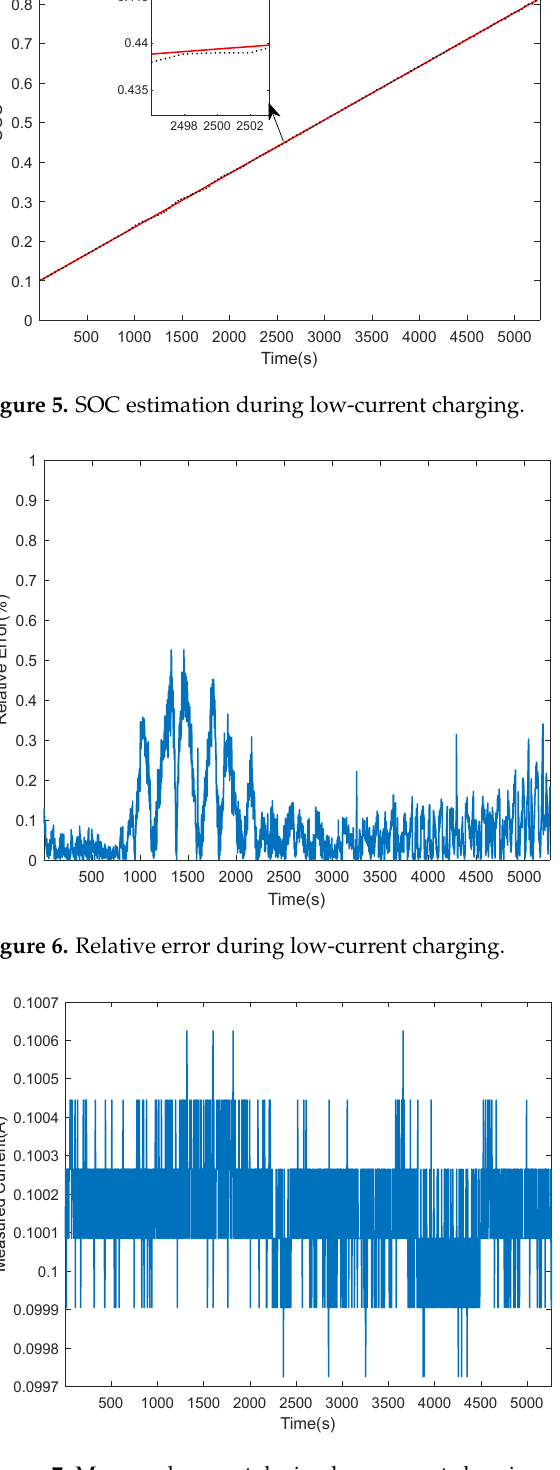
Figure 8. Measured voltage during low-current charging.